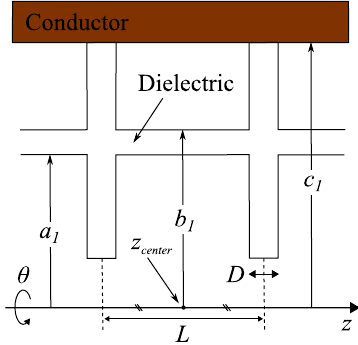
FIG. 2. Longitudinal cross section of the regular